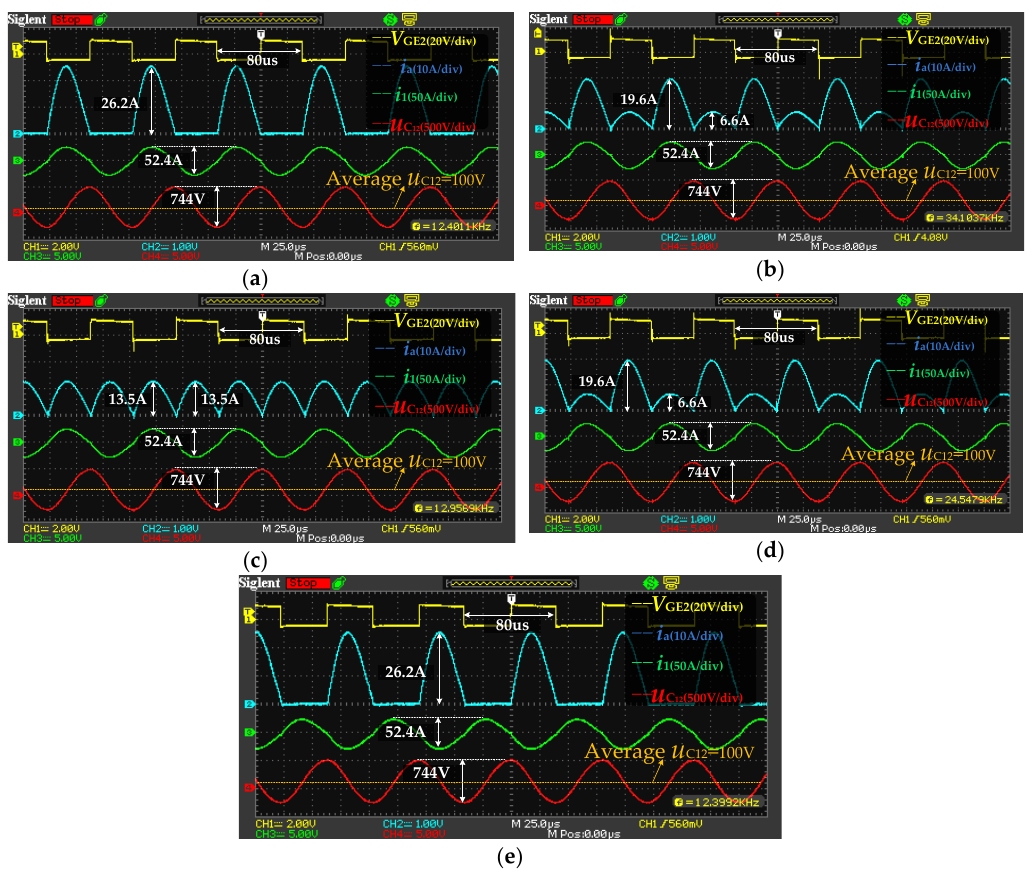
Figure 11. Steady-state operational waveforms of different α: ( a ) α = ∞ ; ( b ) α = 3; ( c ) α = 1; ( d ) α = 1/3; ( e ) α = 0.